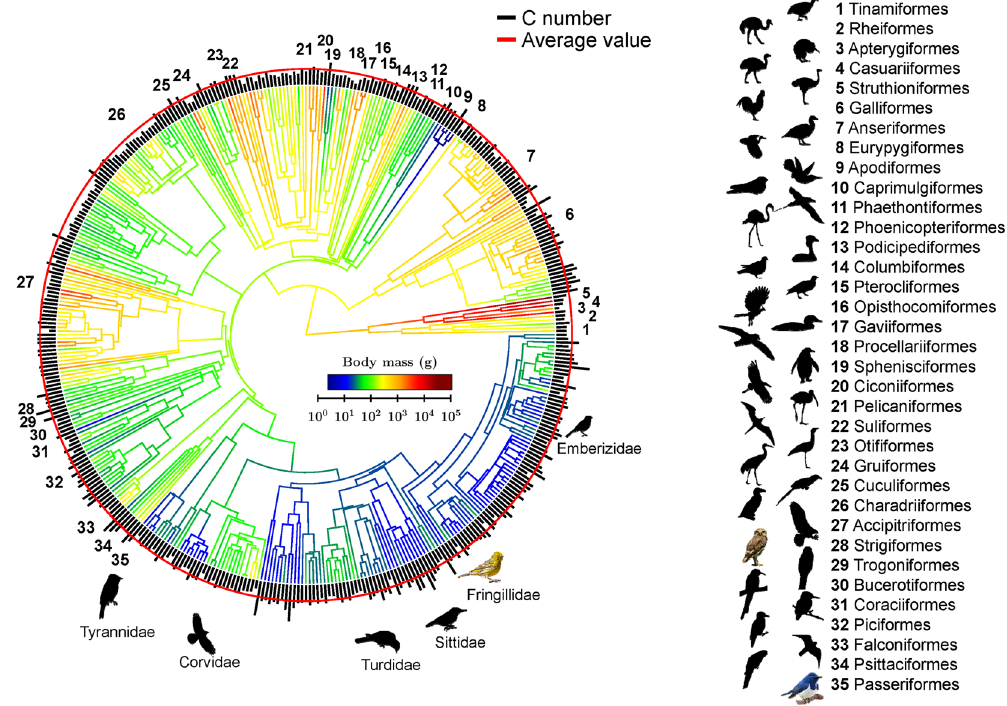
Figure 4. Evolution of body mass and C number. A phylogeny of 416 species, studied by Method 2, for which DNA sequencing data exist 18 . The C number for each species is represented by black line length (linear scale) at branch tips. The red circle indicates the average value ( C = 15,000). The branch color indicates the body mass (log scale). Bird images for representative species in each order are shown (see Supplementary Dataset 2 for details). Bird images not to